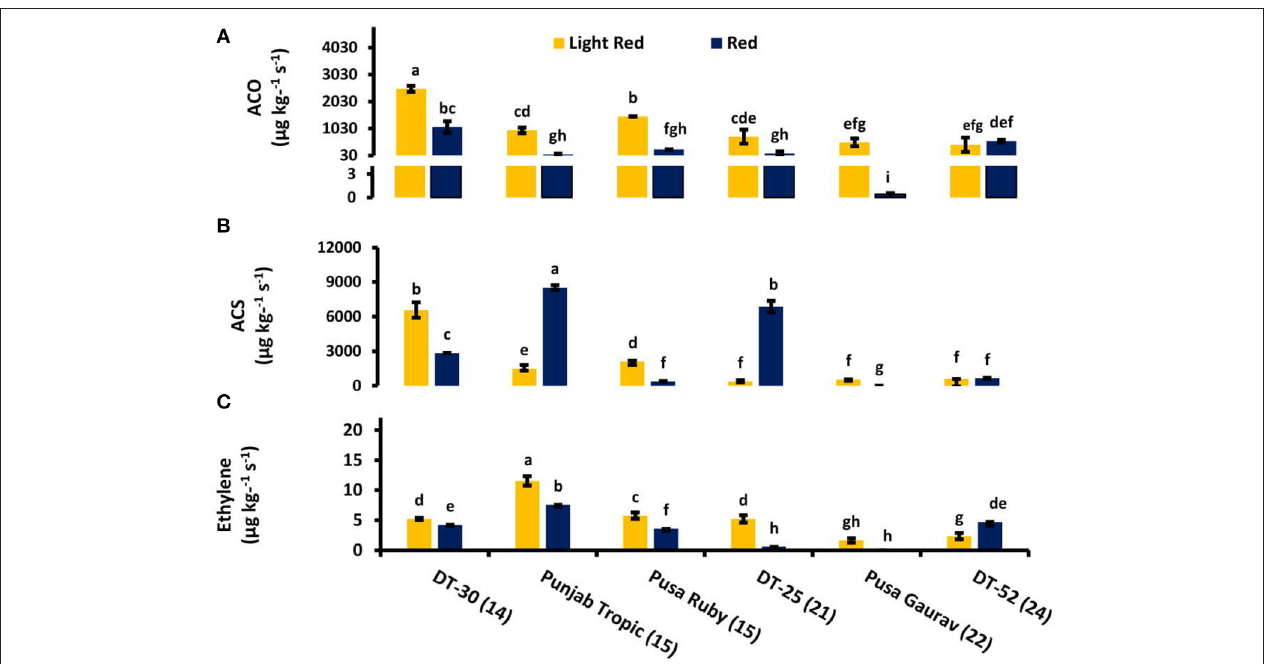
FIGURE 4 | Comparison of (A) 1-aminocyclopropane-1-carboxylic acid (ACC) oxidase activity, (B) ACC synthase activity, and (C) ethylene (ET) evolution at light red and red stage. The bottom axis represents the name of tomato lines, and numbers enclosed in parentheses represent shelf life. Measurements were conducted in three replicates. Results are presented as means ± SE. Different letters represent significant differences at P <